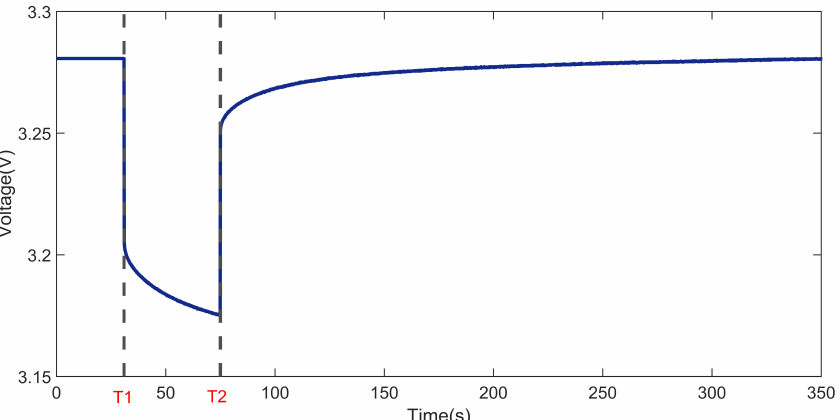
Figure 1. Potential difference between electrodes when the battery is loaded with an initial instanta- neous